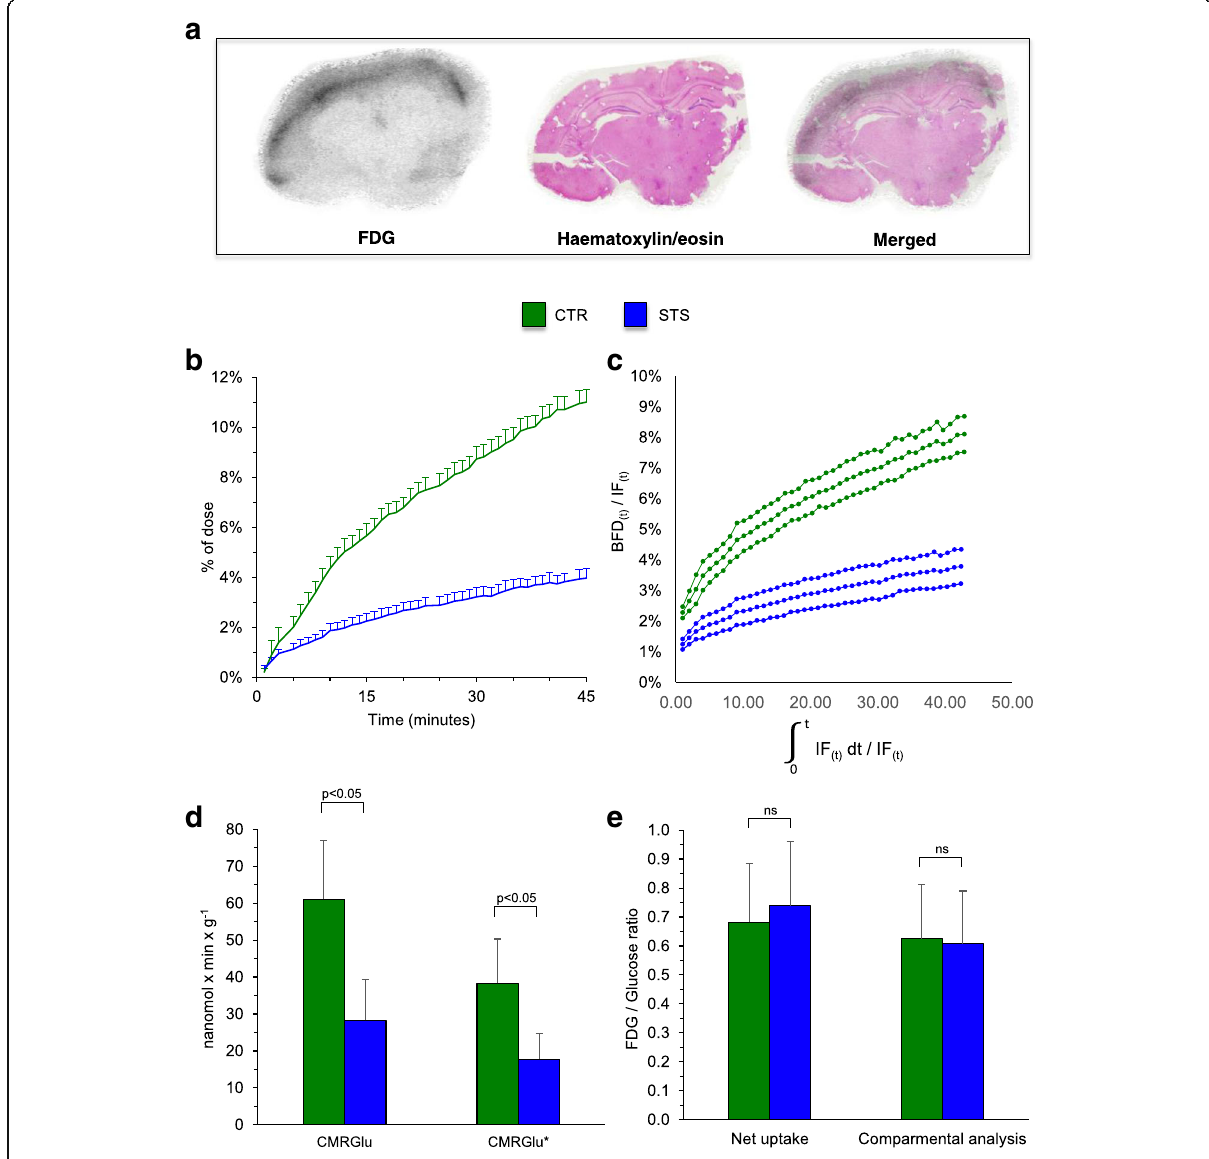
Fig. 3 Ex vivo evaluation of CMRGlu and CMRGlu*. a The autoradiography (first image), its co-registration with hematoxylin/eosin staining (second picture) and the merging of the two results (third image). b The FDG time-activity curves expressed in percentage of dose. c The Patlak regression plot. In each graph, control (CTR) mice are represented in green and starved (STS) mice in blue. d The CMRGlu (left) and CMRGlu* (right) values expressed in nmol × min − 1 × g − 1 . e The lumped constant value obtained as